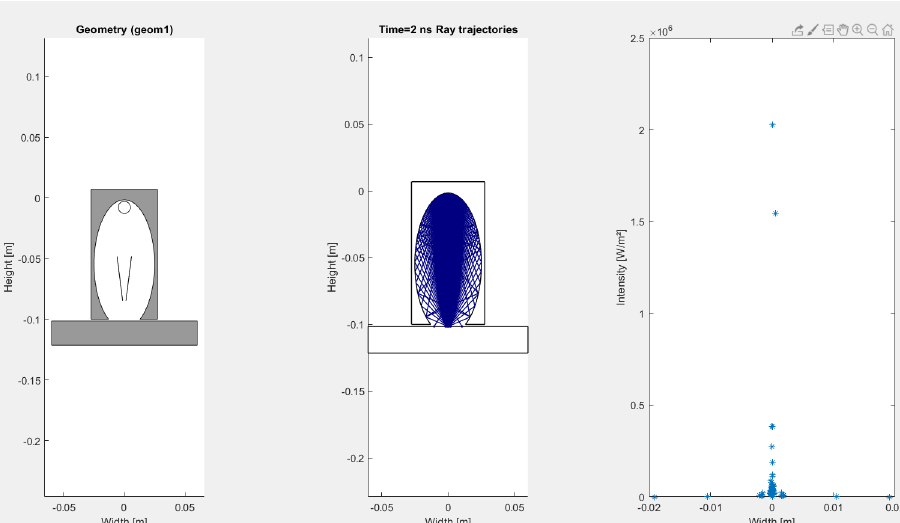
Figure 5. The optimised reflector shape as a result of the ray-tracing simulation can be found on the left, the rays are in the middle, and the intensity of each ray and the width of the heated region are in the right image. This reflector shape resulted in the smallest heated region and has the least adverse effects if the halogen tube lamp is placed at a non-optimal height. Other reflector shapes that were investigated are shown in Figure